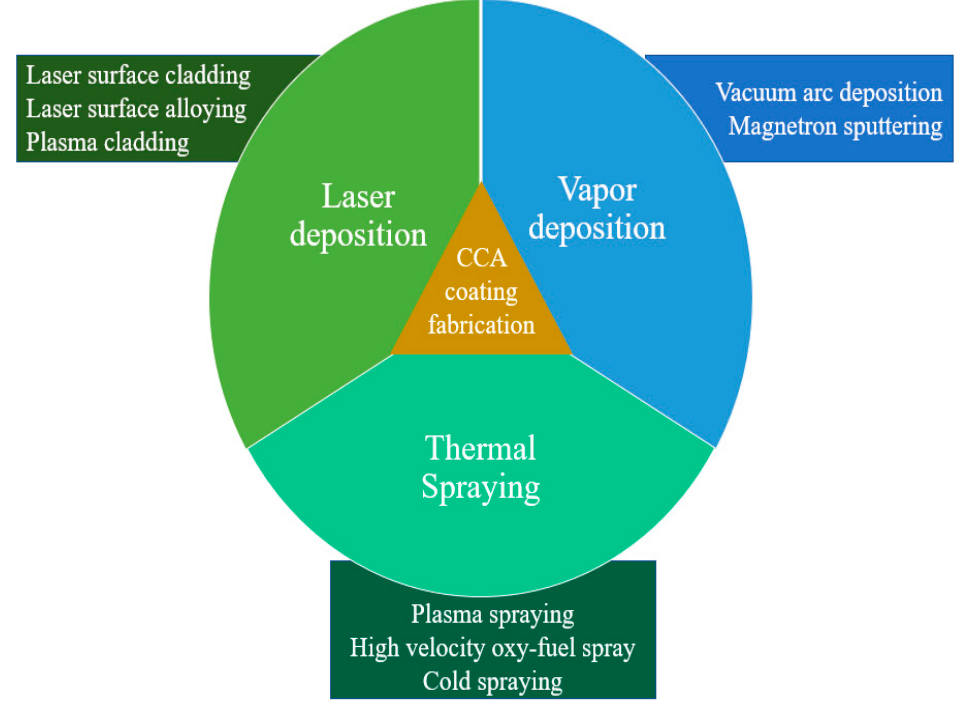
Figure 13. Typical fabrication methods of CCA/HEA coatings [194].